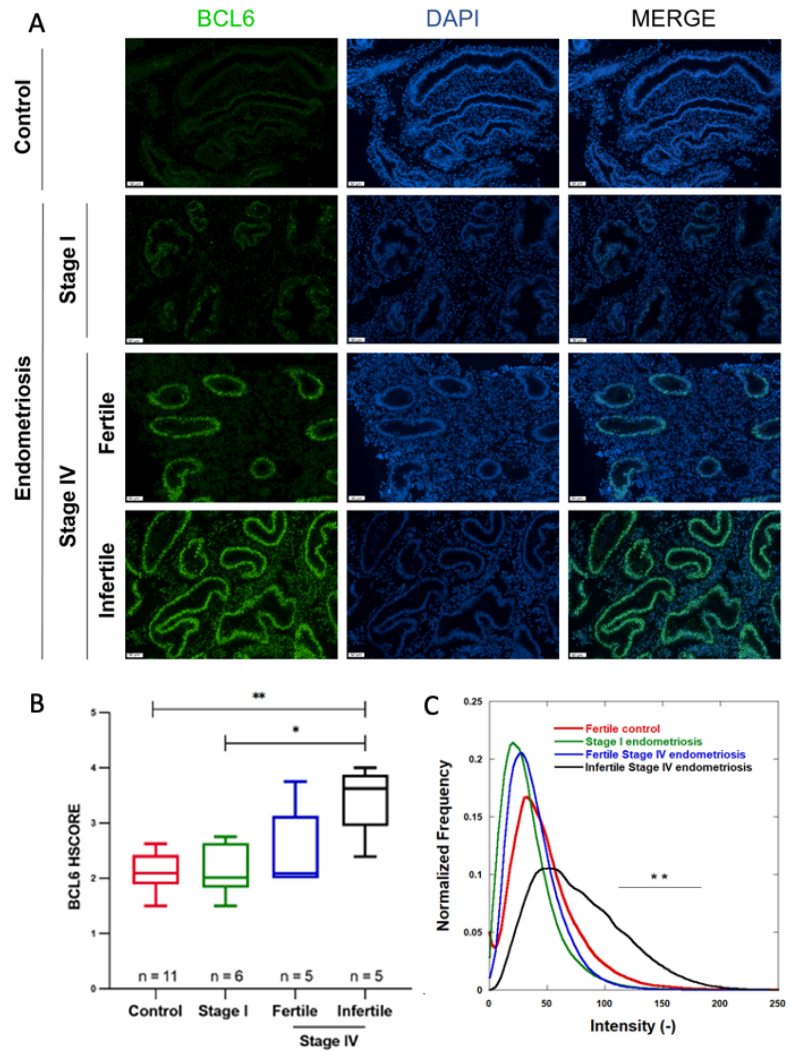
Figure 2. BCL6 expression in endometrium collected during laparoscopy: ( A ) Representative images of BCL6 expression in the endometrium of patients without endometriosis (controls), patients with stage I or stage IV endometriosis with or without associated fertility ( 50 µm); ( B ) BCL6 HSCOREs in control patients ( n = 11) and ( B ) patients with stage I ( n = 6) or stage IV, fertile ( n = 5) or infertile ( n = 5); ( C ) mean normalized BCL6 intensity distributions measured on all scanned sections in each group of patients. * p ≤ 0.05, and ** p ≤ 0.01.